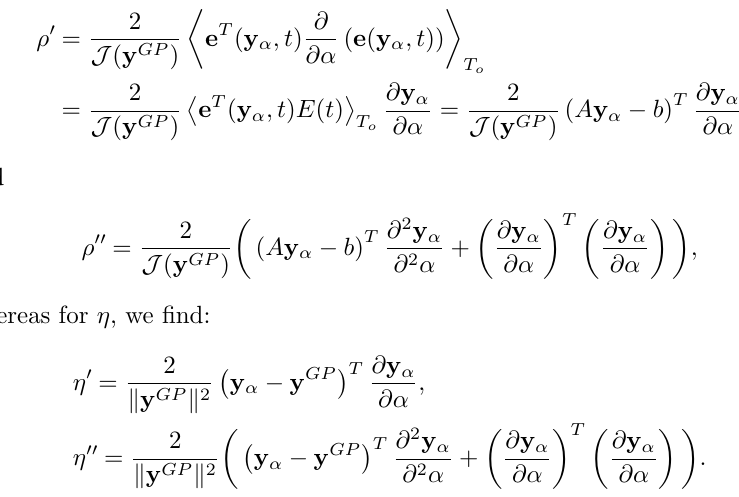
The method of snapshots [23] is then applied to the velocity